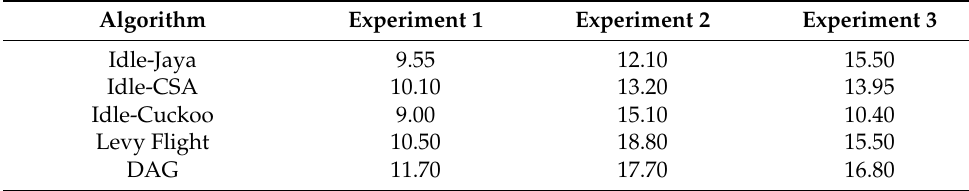
Table 2. The average nectar amount from all simulations.